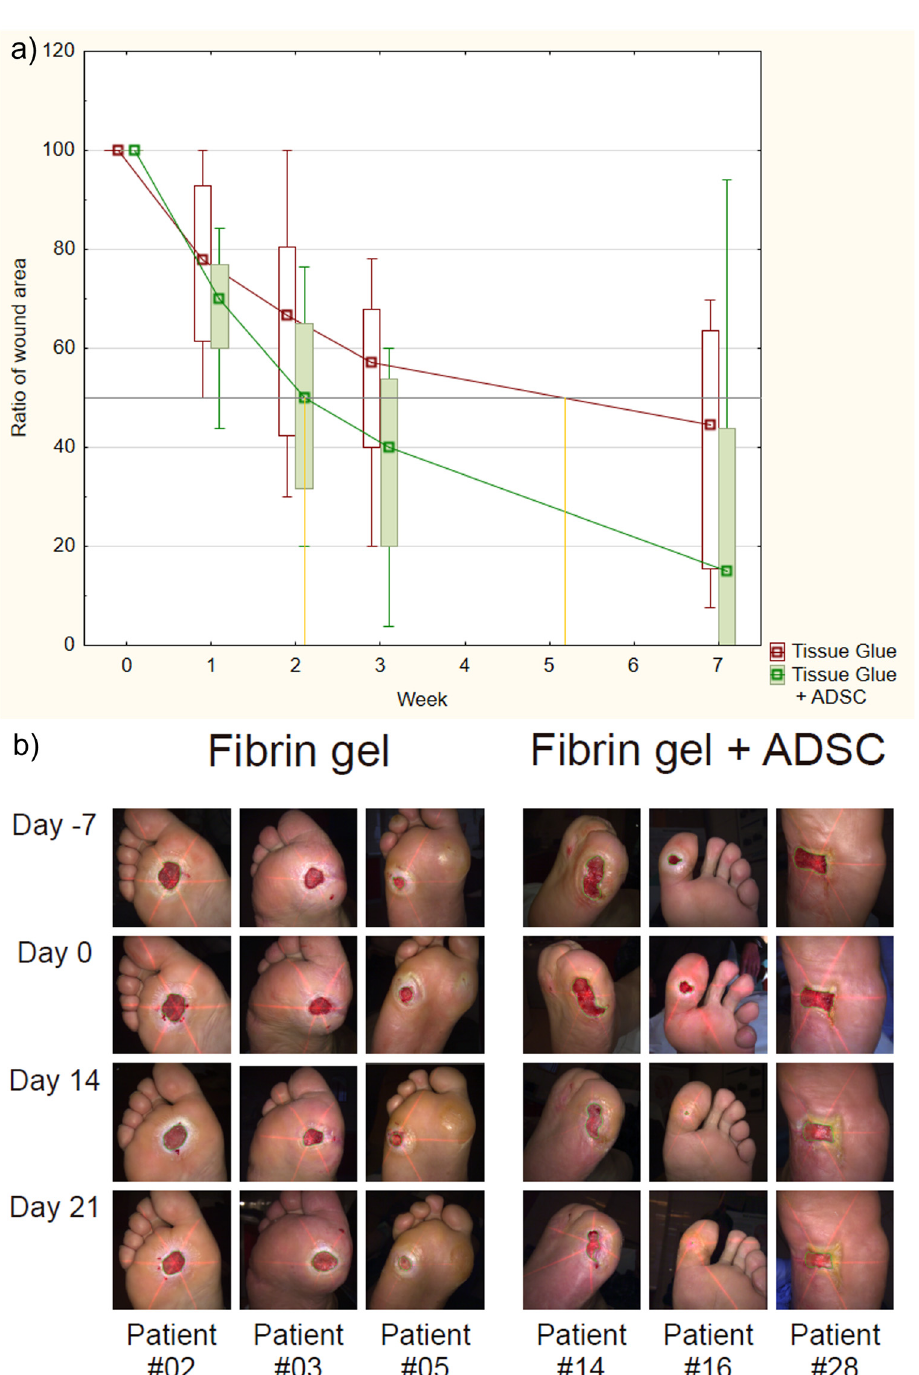
Figure 1. Comparison of fibrin gel group and ADSC group patients’ course of treatment: ( a ) Time dependence of the relative size of the wound in both groups. Relative wound size is defined as the ratio of the wound size at a given week to the size at week zero. At week zero, patients received either tissue glue or tissue glue along with ADSC; ( b ) Photographs of wound areas in the studied groups illustrating the course of DFU treatment in the study and the difference between patients from the fibrin gel group and the ADSC group. Photographs were taken in weekly intervals starting from the screening visit (Day -7), treatment application (Day 0), and two and three weeks into the treatment (Day 14 and Day 21, respectively).